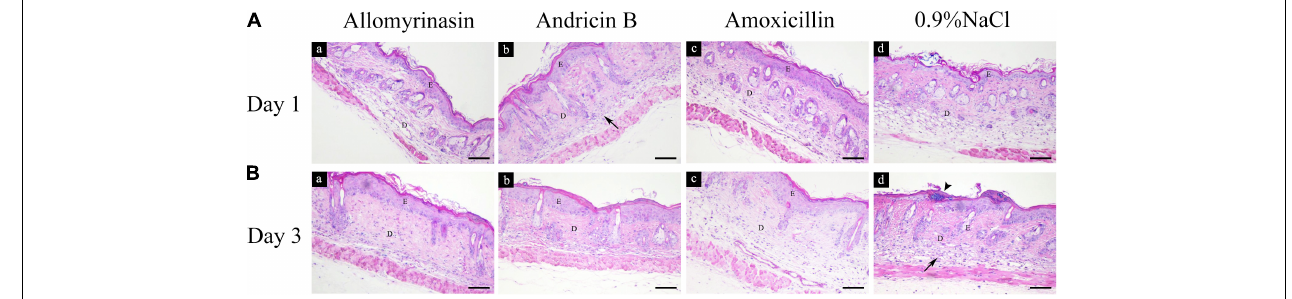
FIGURE 10 | Histopathological analysis of mouse skin tissues infected by Staphylococcus pseudintermedius MW767056, evaluated by hematoxylin and eosin staining. (A) Inflammatory infiltrate (arrow) was mainly detected in the dermis and scattered in the epidermis on day 1. (B) Increased epidermal thickness and an alleviated inflammatory response were observed in all treatment groups, accompanied by staphylococci colonizing the stratum corneum (arrowhead) in the saline-treated group on day 3. The bar represents 100 µ m. E, epidermis; D, dermis.